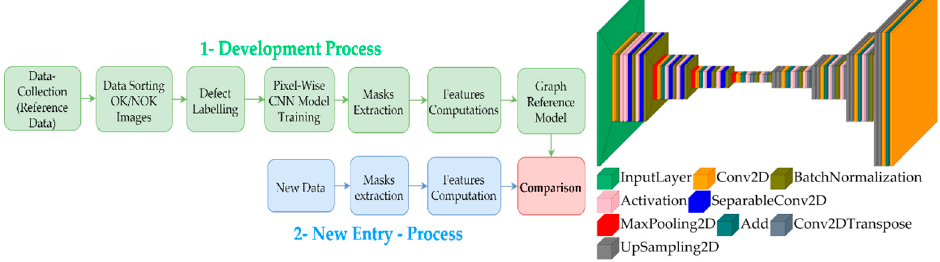
Figure 5. Flowchart of the AQA process ( left ); topology of CNN for anomaly detection ( right ). The CNN has a structure similar to the auto-encoders, but the bottleneck is not used as reduced version of the input image. The main difference between the autoencoder and a pixel-wise CNN model is that the optimization uses a binary map as the ground truth, whereas the autoencoder uses the same input. The input layer is a grayscale image, and the output layer is a binary map of 256 × 256 pixels each. The predicted mask from the CNN was converted into a polygon to further extract all the contours’ complexity C , size QTT , and texture TT . The CNN was trained based on selected images from a dataset with manually classified defective parts. In total, 259 images were selected from the dataset, and due to augmentation, 5800 additional images were created for the CNN training. Figure 6 depicts example of the used augmentations.